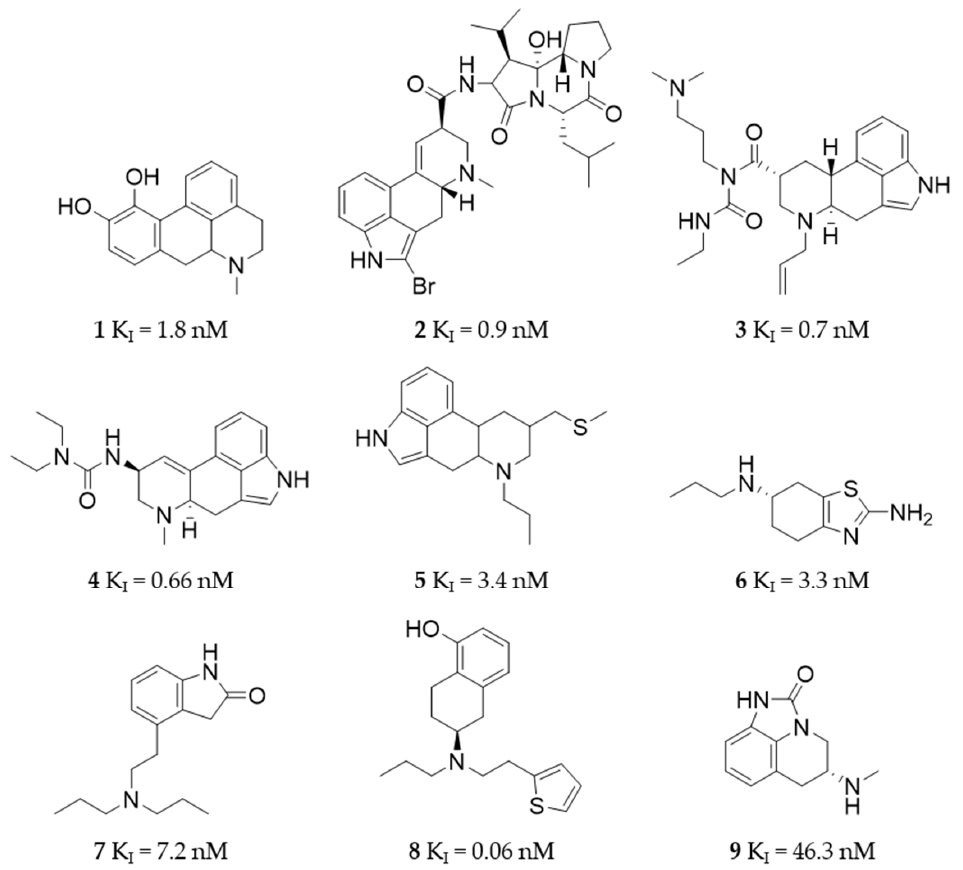
Figure 3. Overview of all clinically used D 2 R agonists. All compounds were included in the active dataset used during the generation and validation of the developed pharmacophore models. The compounds were retrieved from the ChEMBL database including their in vitro K I values (nM).